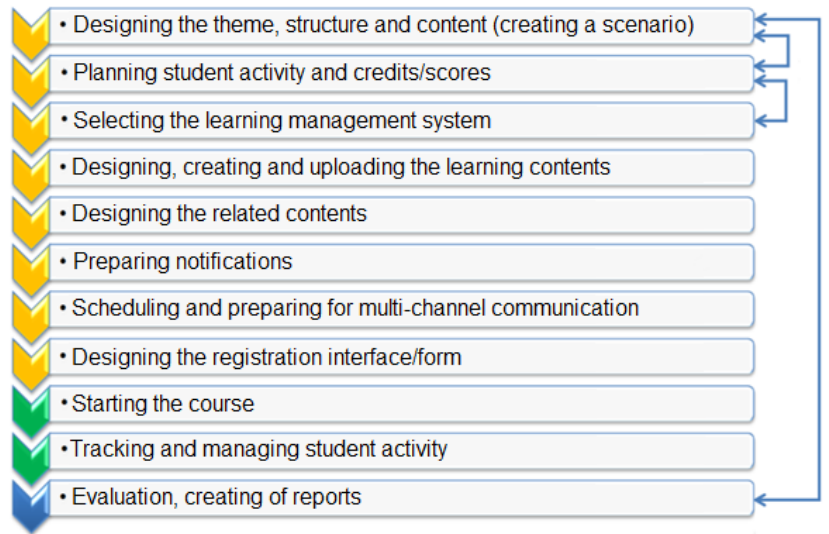
Figure 2. Theoretical model for design and creation of educational materials.